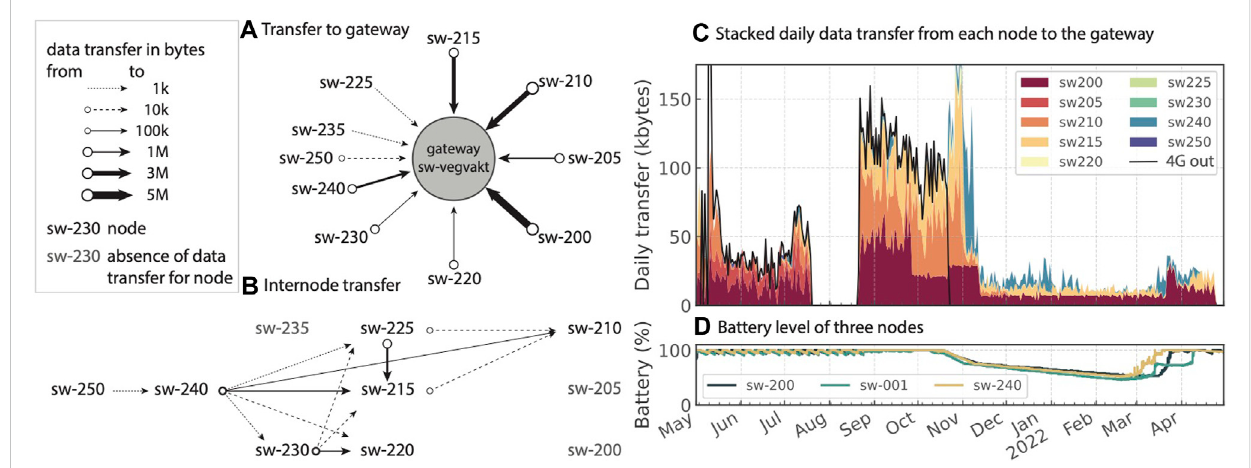
FIGURE 6 Variations in data volume transferred to the gateway sw-vegvak and between nodes at Kongsvegen for the period May 2021- May 2022. Schematic summaryoftransfers (A) fromallnodestothegatewayand (B) internodaltransferbetweennodes. (C) Temporalvariationsindatatransferfromeachnode to thegateway sw-vegvakand (D) inbattery level for threenodes.The volume ofdata sent from thegateway to theserverby4G (black line) adaptsto the volume of received data until its failure on 22nd